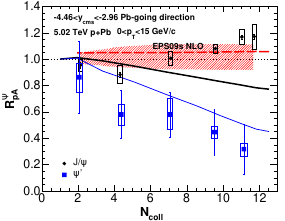
Figure 3. J /ψ and ψ (2 S ) nuclear modification factor as a function of the number of binary collisions in the backward rapidity at √ s NN = 5 . 02 TeV p-Pb collisions. The figure is cited from